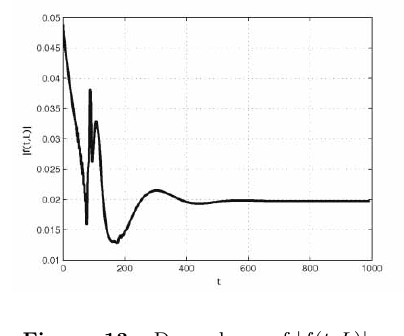
Figure 13. Dependence of | f ( t,L ) | on t (new), λ = 1, L = 113 . 7, τ = 0 , 0496, h = 0 ,